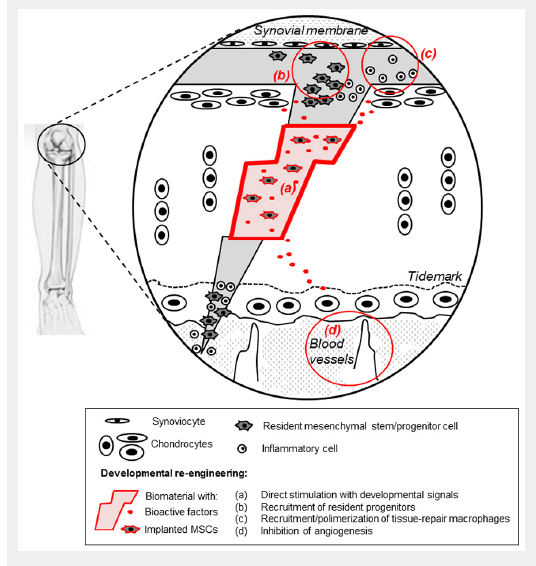
MSC = mesenchymal stromal/stem